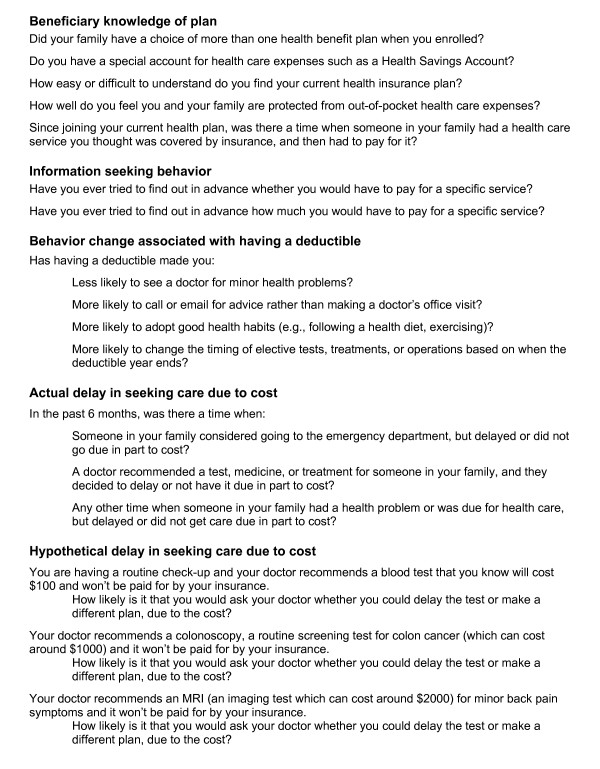
Test-retest questions.